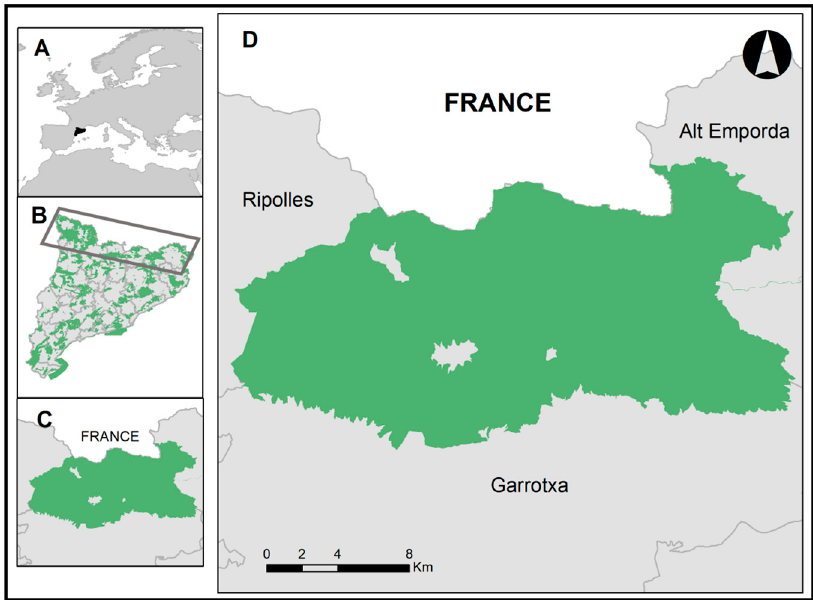
Figure 1. Study area ( A ) Catalonia, Spain; ( B ) Protected natural area and Pyrenees; ( C ) Alta Garrotxa protected natural area; ( D ) detailed study area.